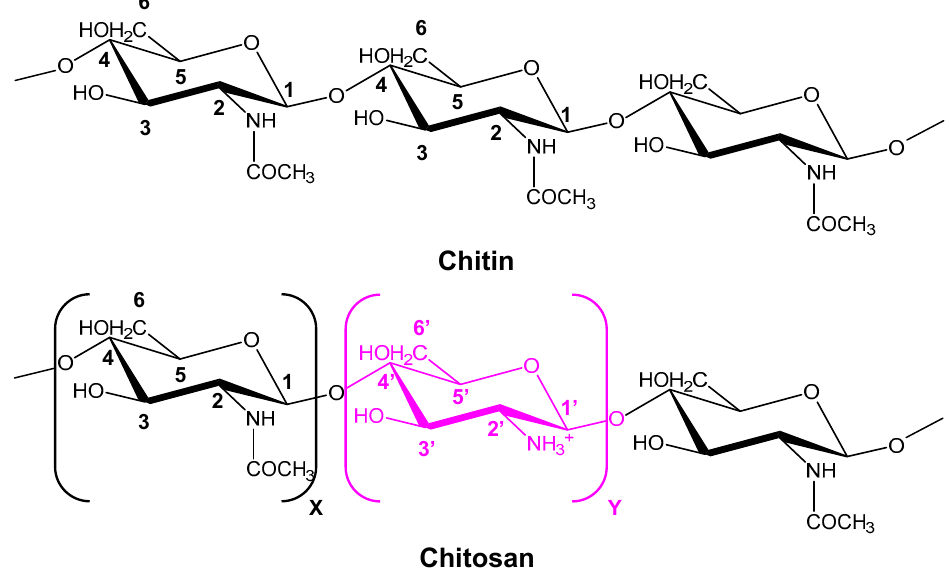
Figure 7. Schematic representation of chitin and chitosan. The relative values of X and Y determined the deamidation degree of the chitosan.